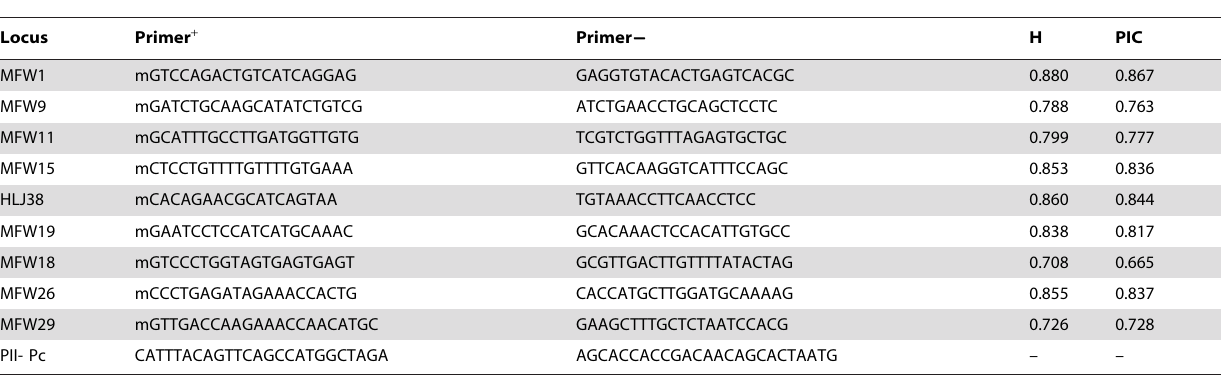
Table 1. Primers used for PCR amplification.